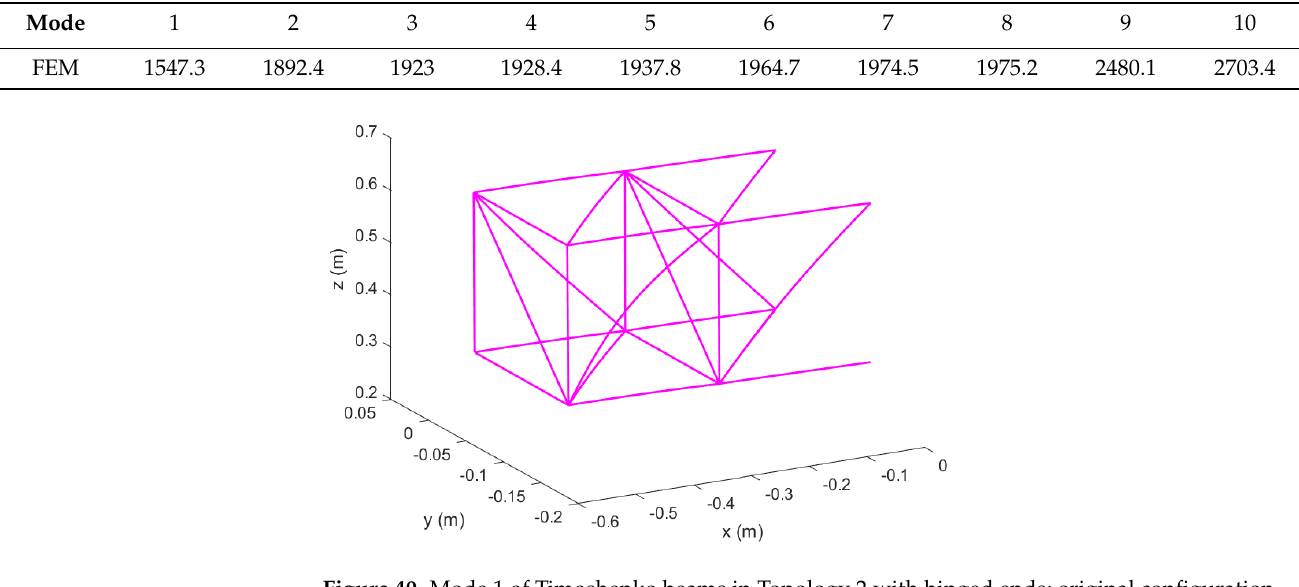
Figure 40. Mode 1 of Timoshenko beams in Topology 2 with hinged ends; original configuration.